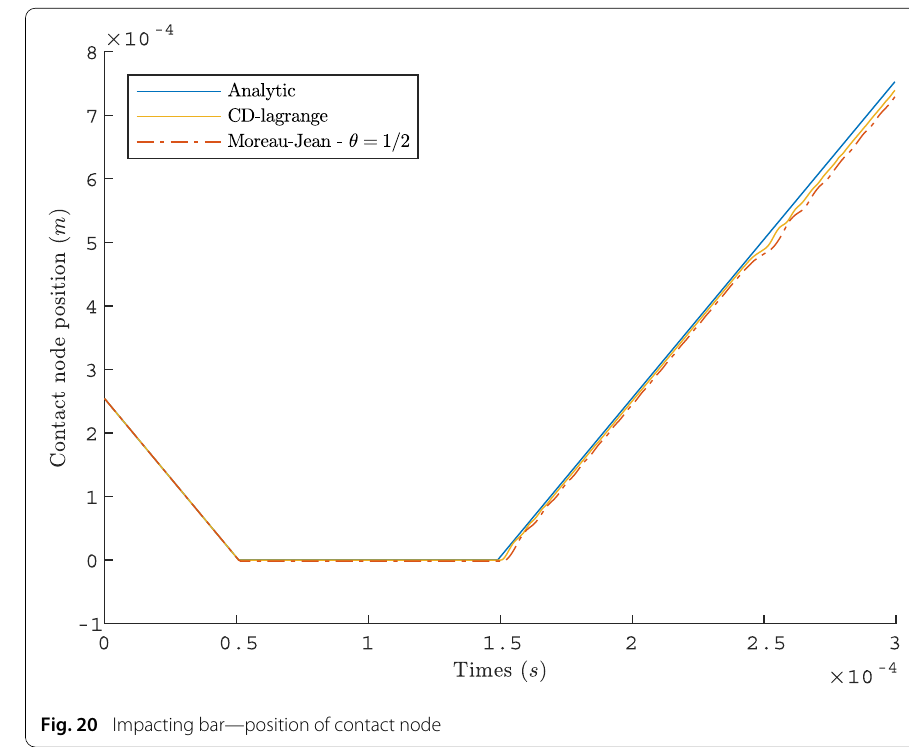
Fig. 20 Impacting bar—position of contact node